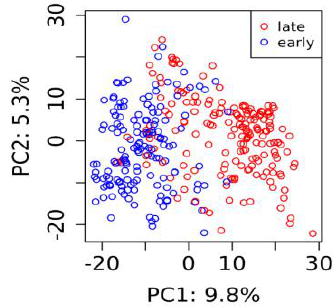
Figure 3. Principle component analysis (PCA) for the tested plant lines with 2785 single-nucleotide polymorphism (SNP) markers. The coloring indicates early (blue) and late (red) maturing lines.